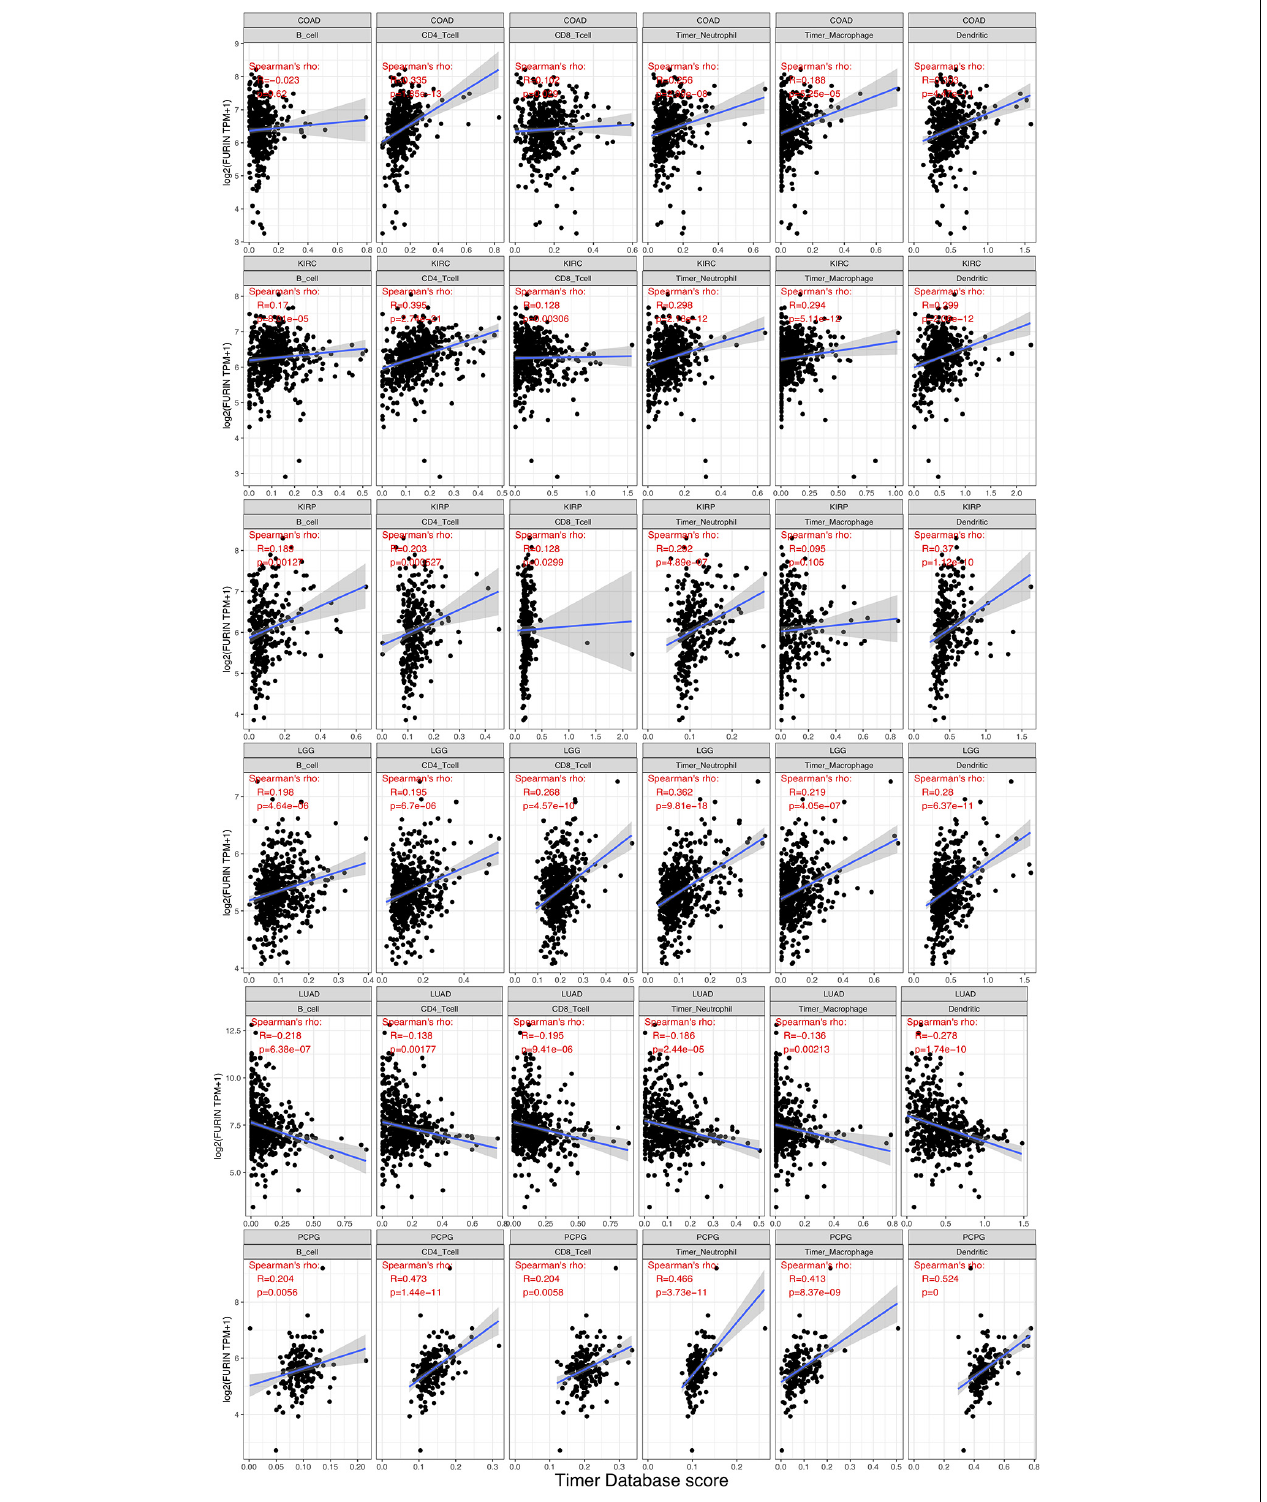
FIGURE 5 | FURIN expression positively correlates with immune infiltration levels in COAD, KIRC, KIRP, LGG, and PCPG. FURIN expression negatively correlates with immune infiltration levels in LUAD.